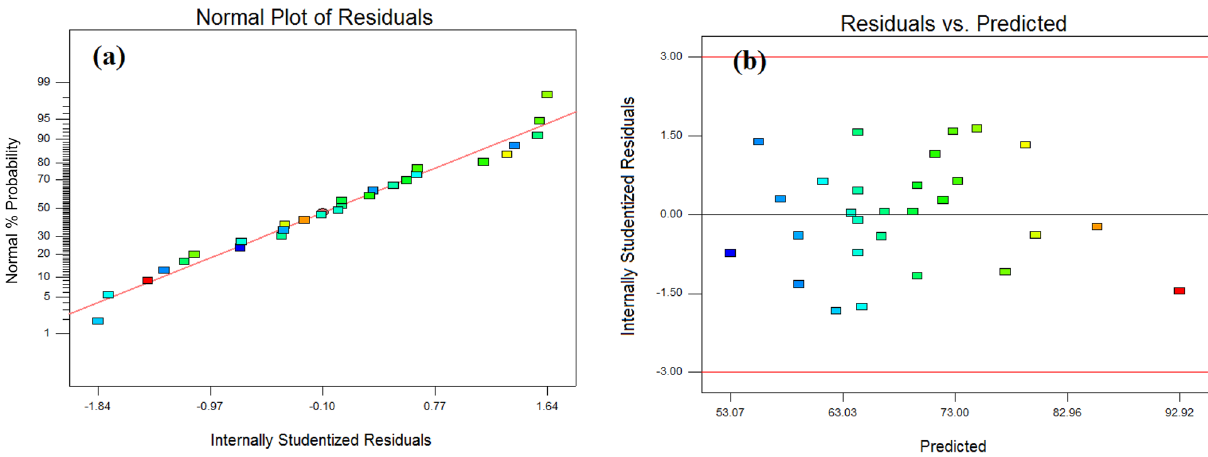
Figure 2. The normal plot of residual values ( a ), the diagnostic plot of residuals versus predicted values ( b